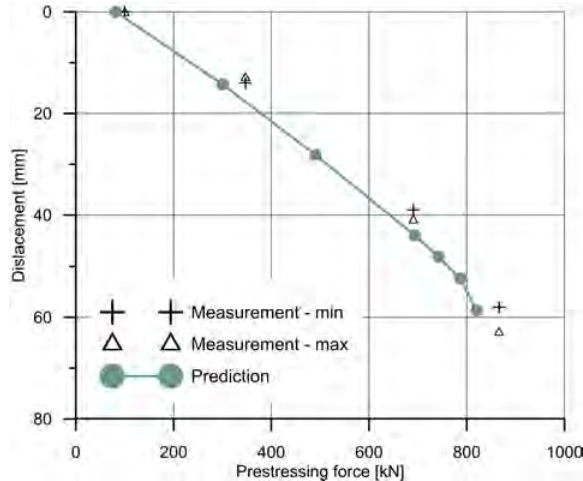
Figure 12. Computed and measured load displace- ment curves.